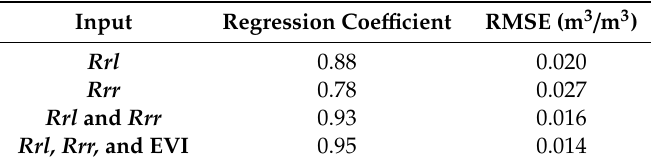
Table 2. Regression coefficient and RMSE of 4 neural networks.